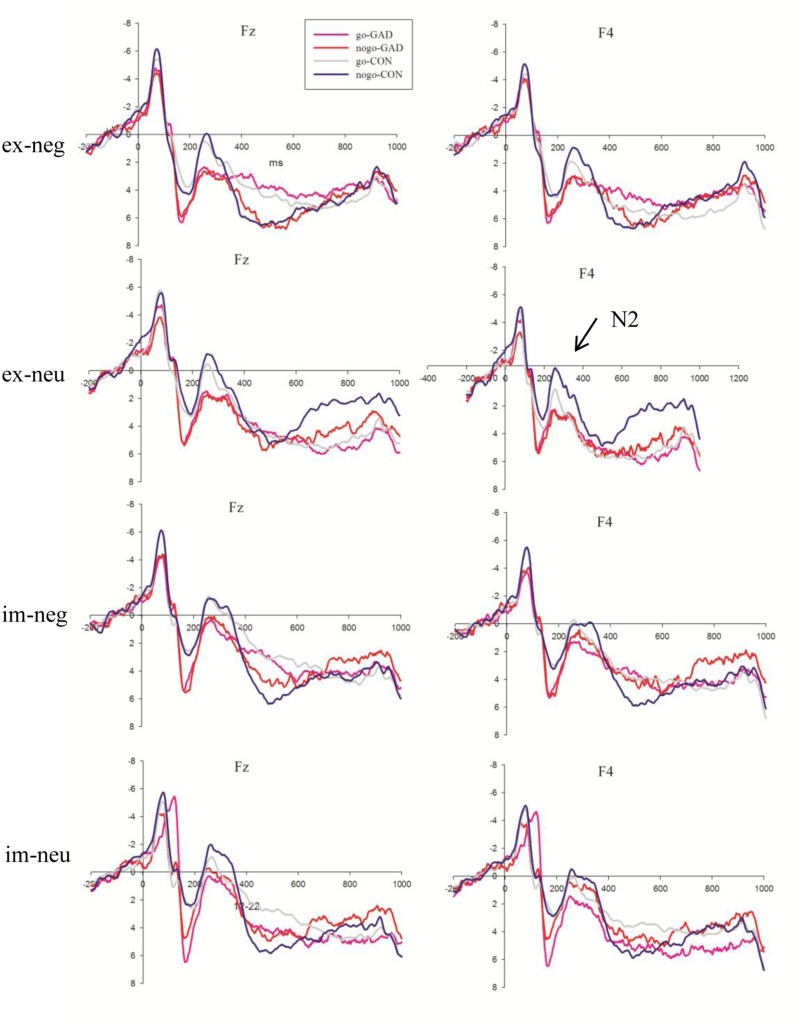
The N2 average waves evoked by go and no-go stimuli in GAD group (red lines; pink lines) and control group (blue lines; gray lines) in explicit negative, explicit neutral, implicit negative, implicit neutral conditions at Fz, F4 sites (GAD, general anxiety disorder; CON, control; im, implicit; ex, explicit; neg, negative; neu, neutral).